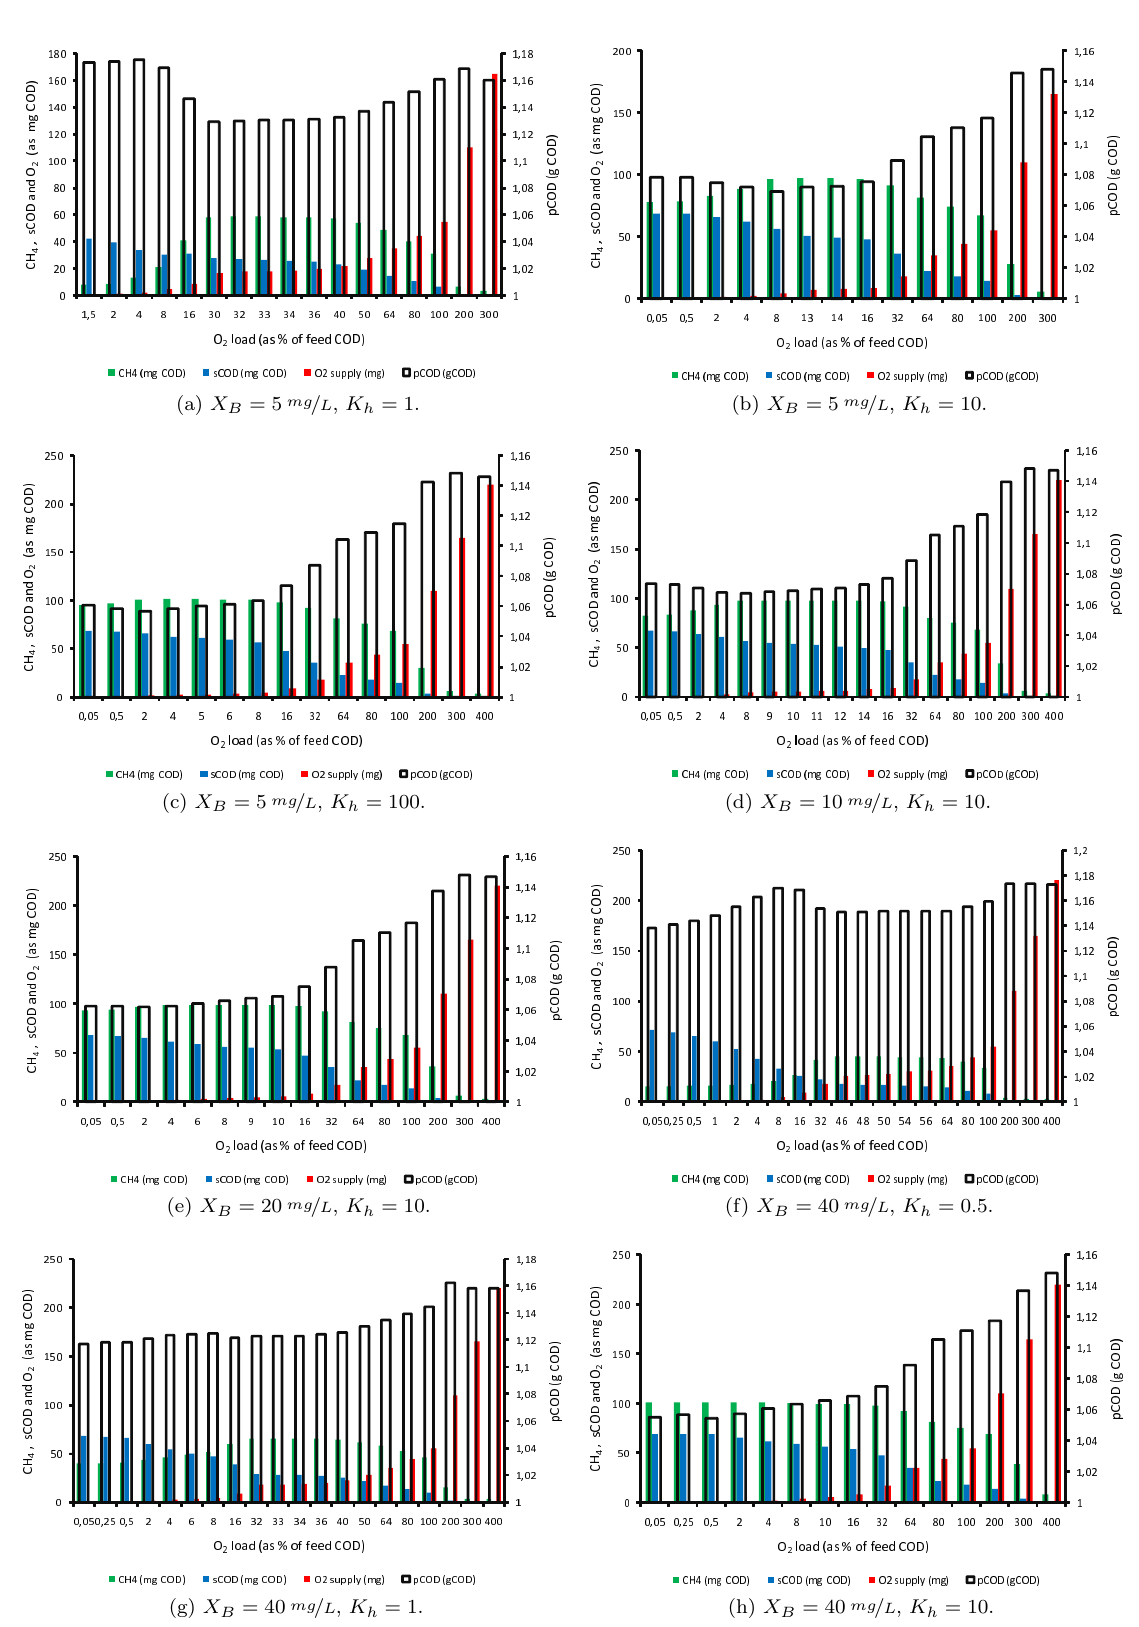
Figure 6: (a-h): COD distributions at various oxygenation levels with different operating conditions of X B and K h (fixed k L a = 4000 d − 1